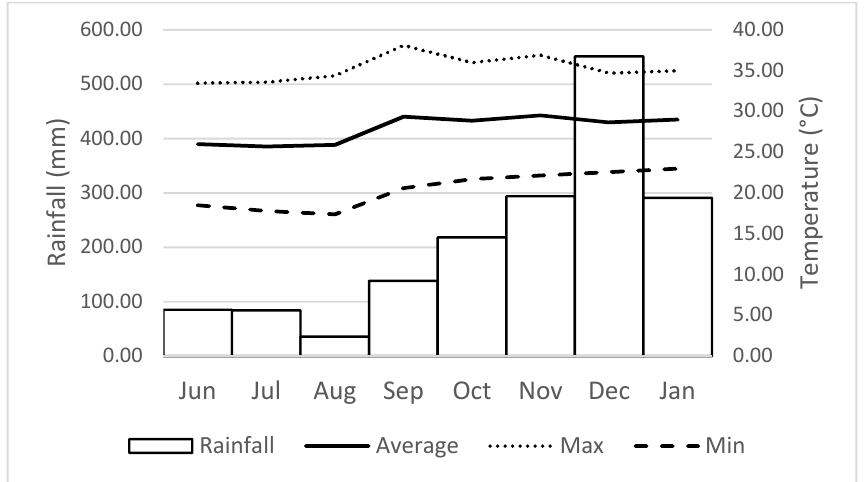
Figure 3. Rainfall and monthly temperature between June 2019 to January 2020 in the Madre de Dios Region, Peru. Months are represented by their first three letters. Max: Maximum, Min: Minimum.